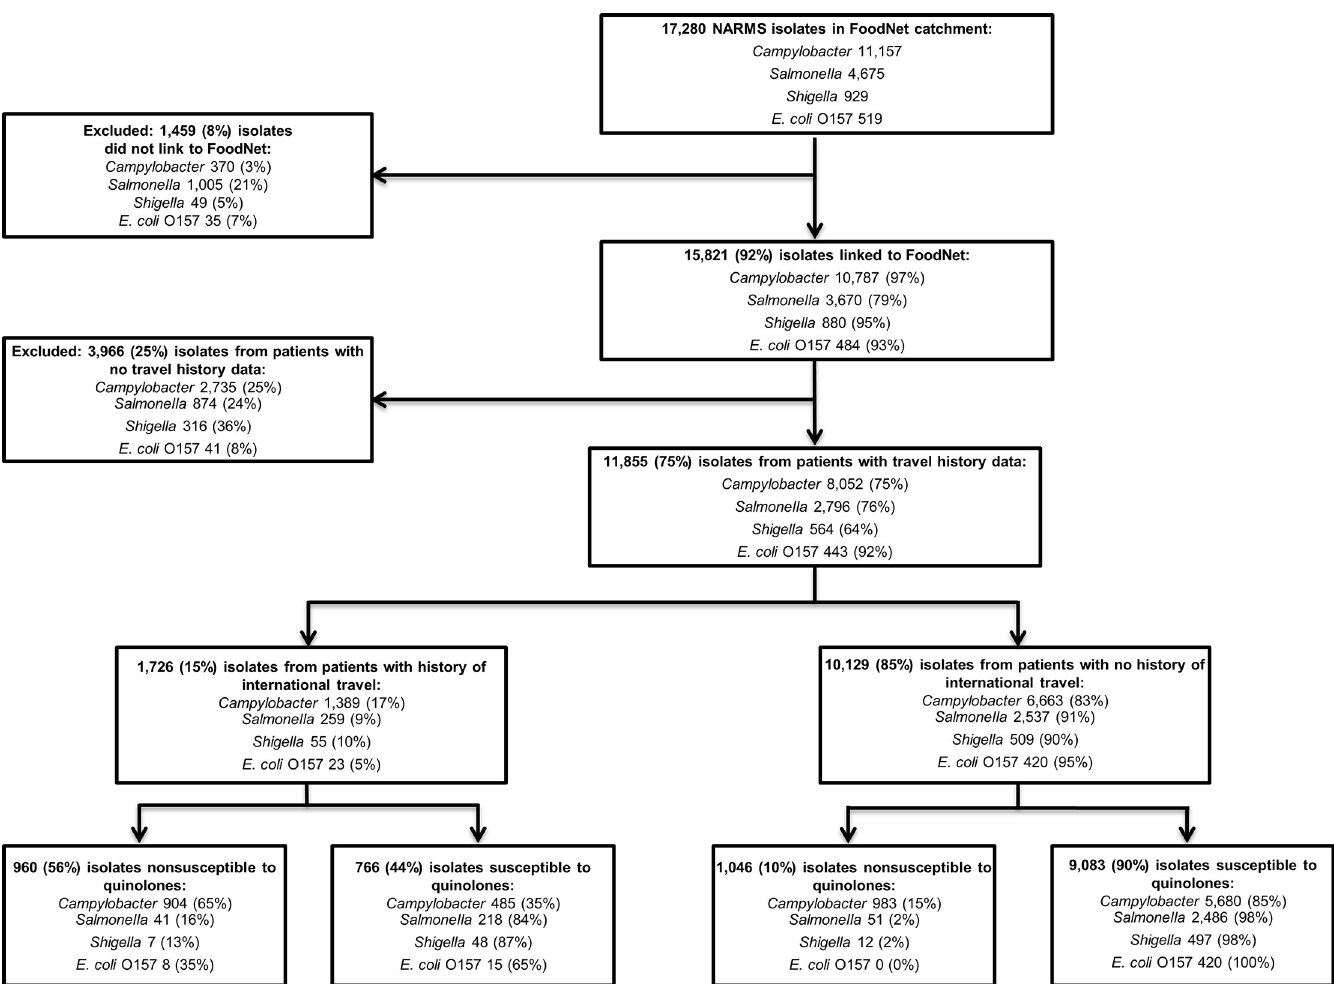
Fig 1. Number and percentage of National Antimicrobial Resistance Monitoring System (NARMS) isolates included in the study from patients in the FoodNet catchment area with a reported history of international travel, by pathogen, 2004–2014.